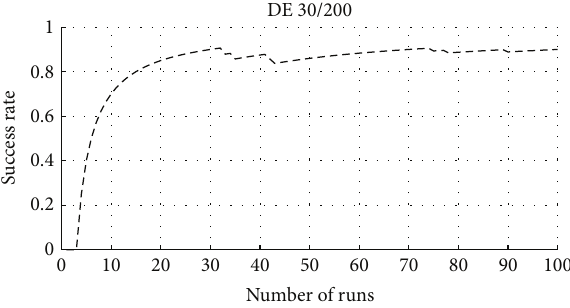
Table 9: Bounds on design variables for Cassini 2 mission: